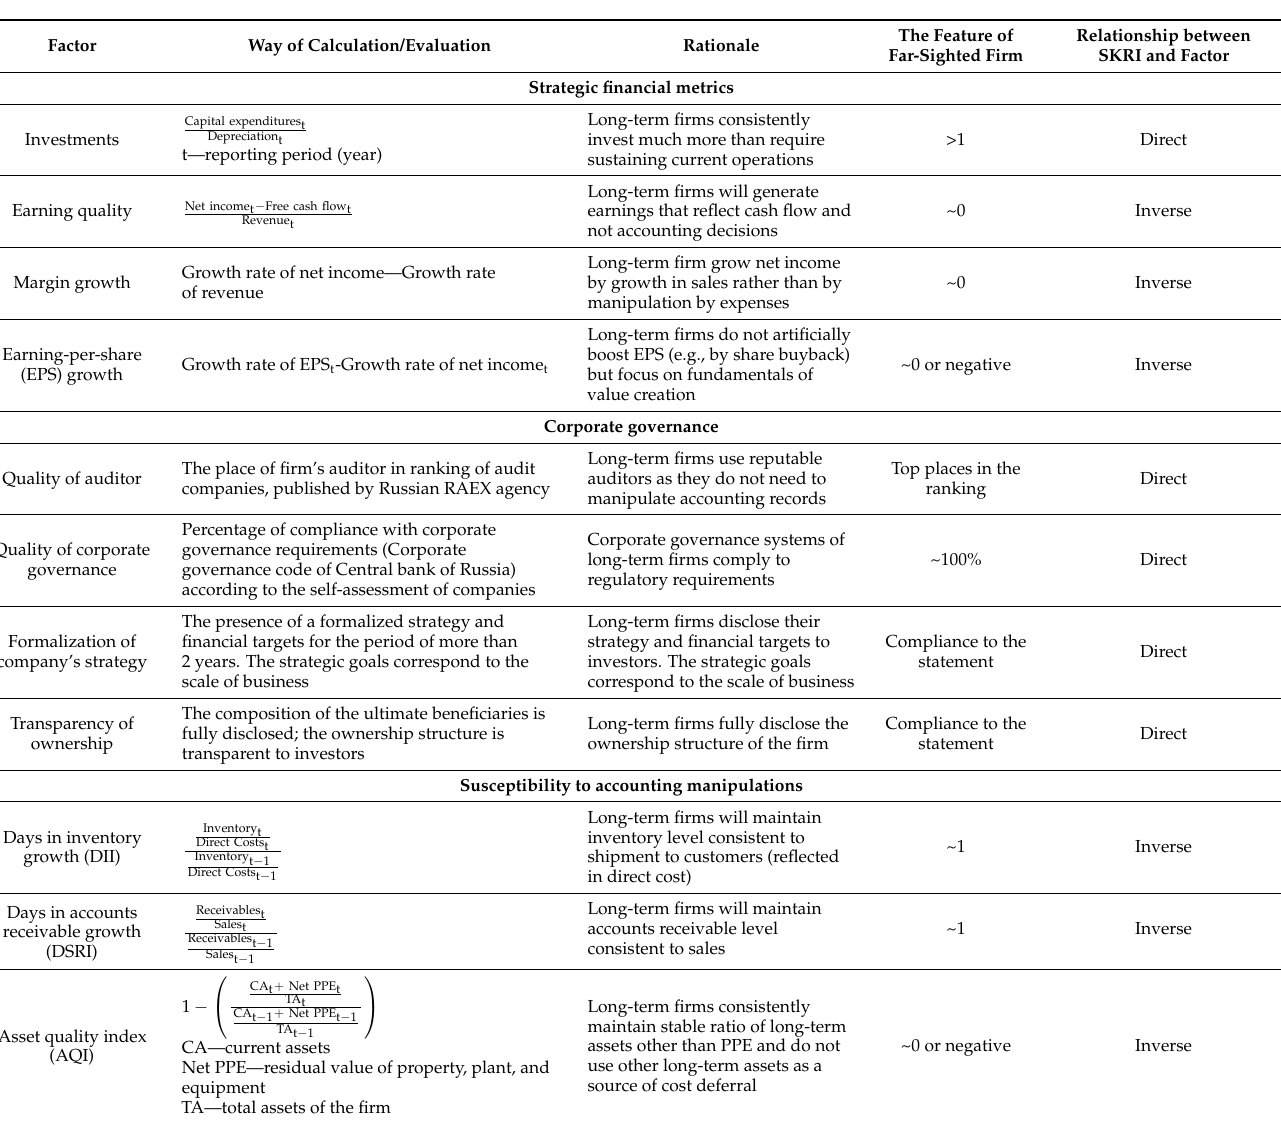
Table 1. Key indicators of